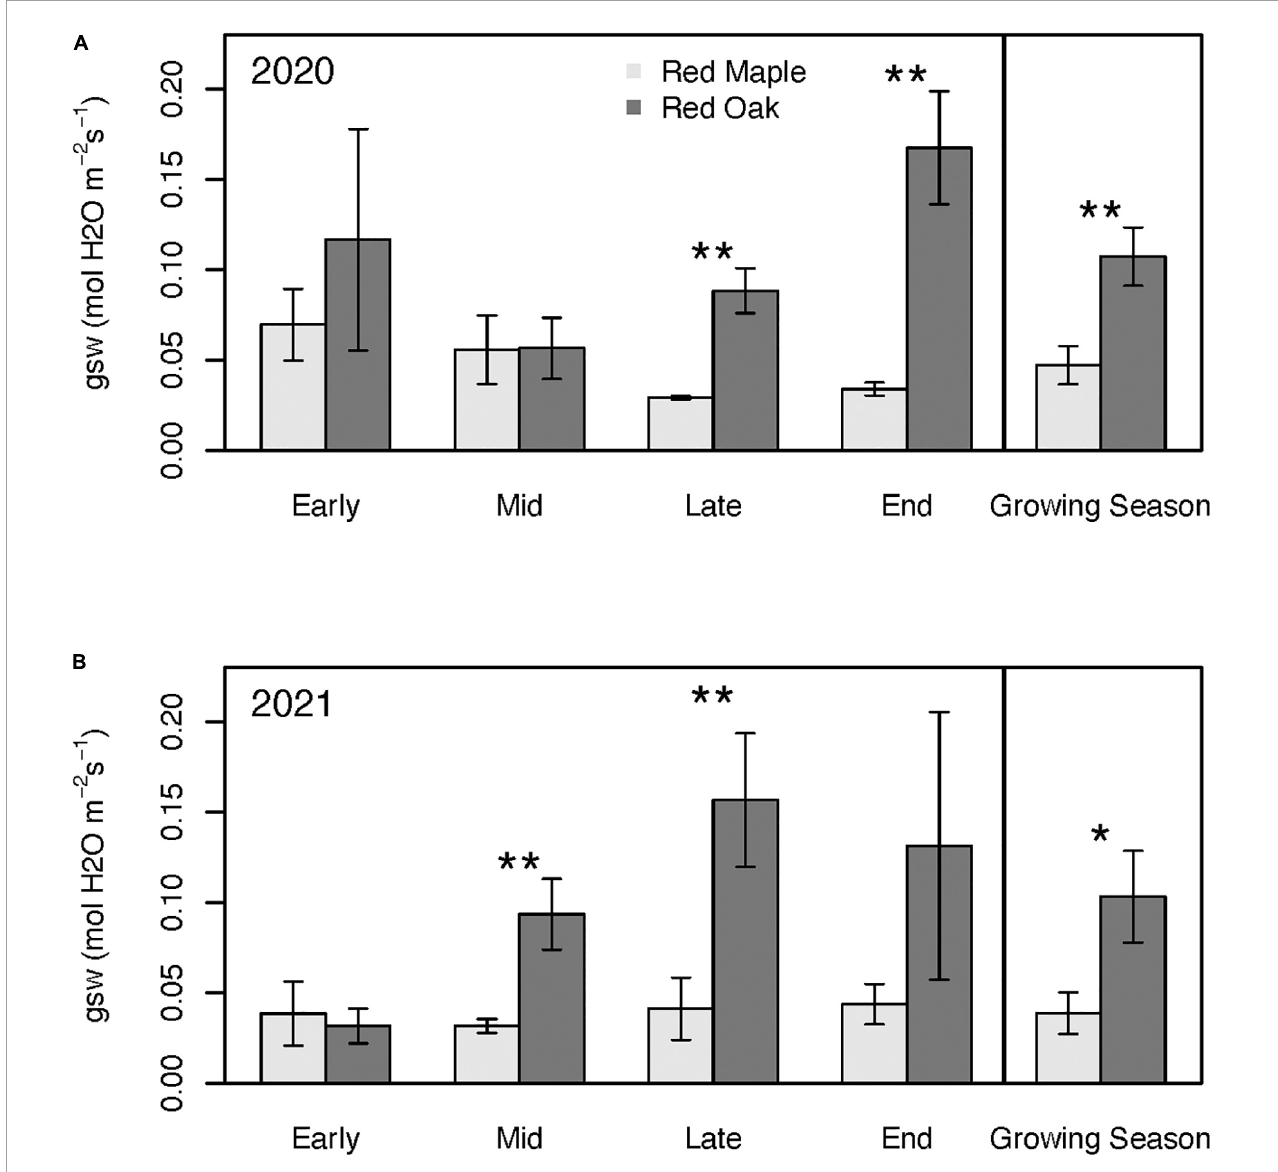
FIGURE6 Stomatal conductance (gsw) across the growing season and for the mean of the entire growing season during 2020 (i.e., year with oak-defoliating frost) (A) and 2021 (i.e., year without defoliating frost); (B) for red maple and red oak leaves. Asterisks denote differences between species within a year at ** p < 0.05 and * p < 0.1. There were no significant interannual differences within a species. See Supplementary Tables 2A, B for summary